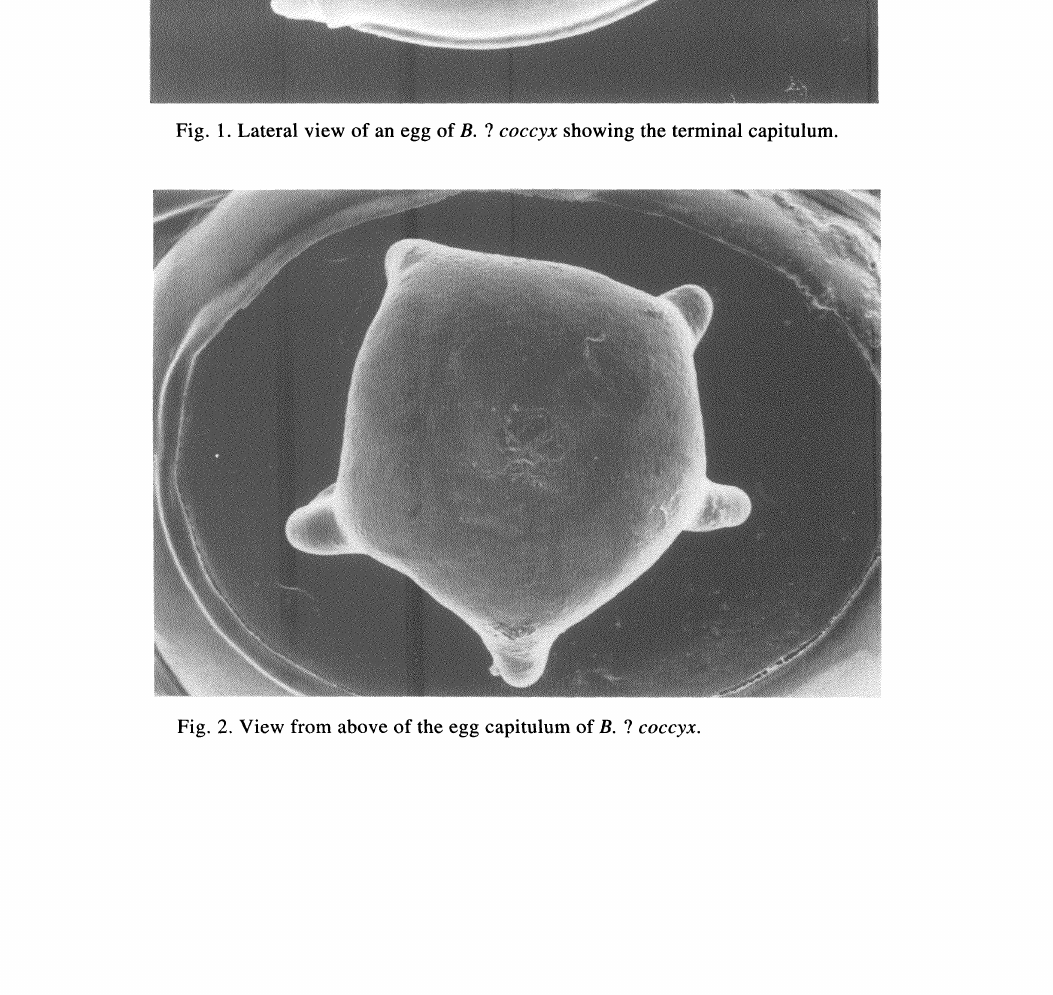
Fig. 1. Lateral view of an egg of B. ? coccyx showing the terminal capitulum.